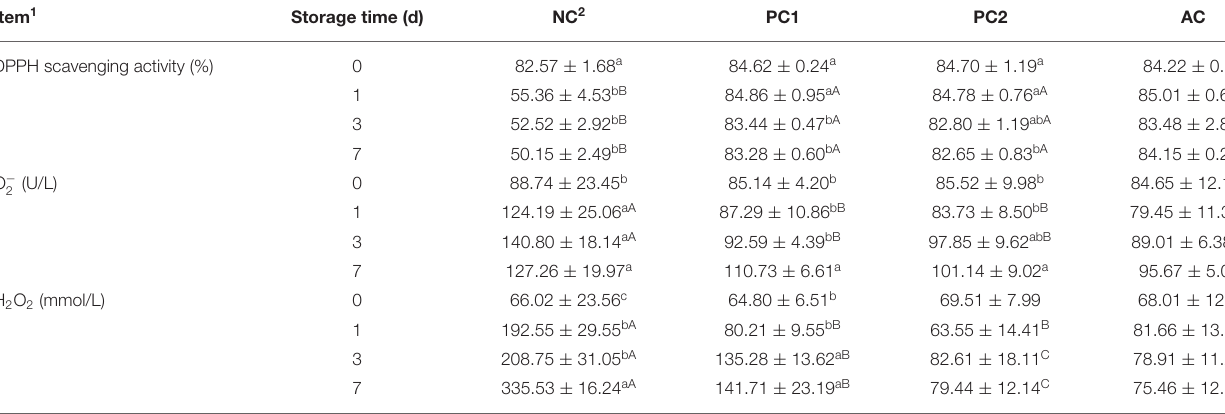
TABLE 3 | Effect of PCP on free radical parameters in milk during storage period. Item 1